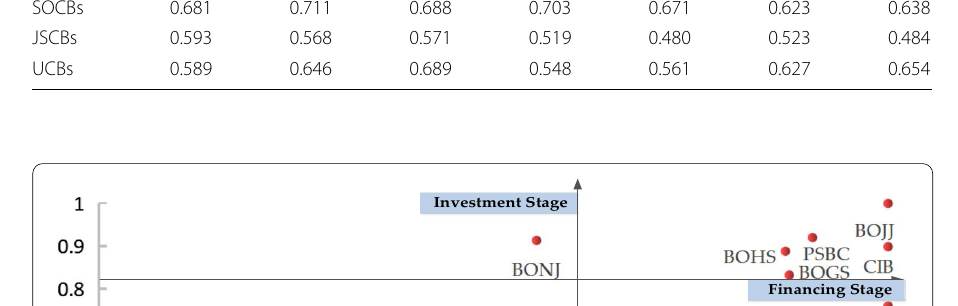
Table 8 Efficiency of the investment stage from 2012 to 2018 Cluster